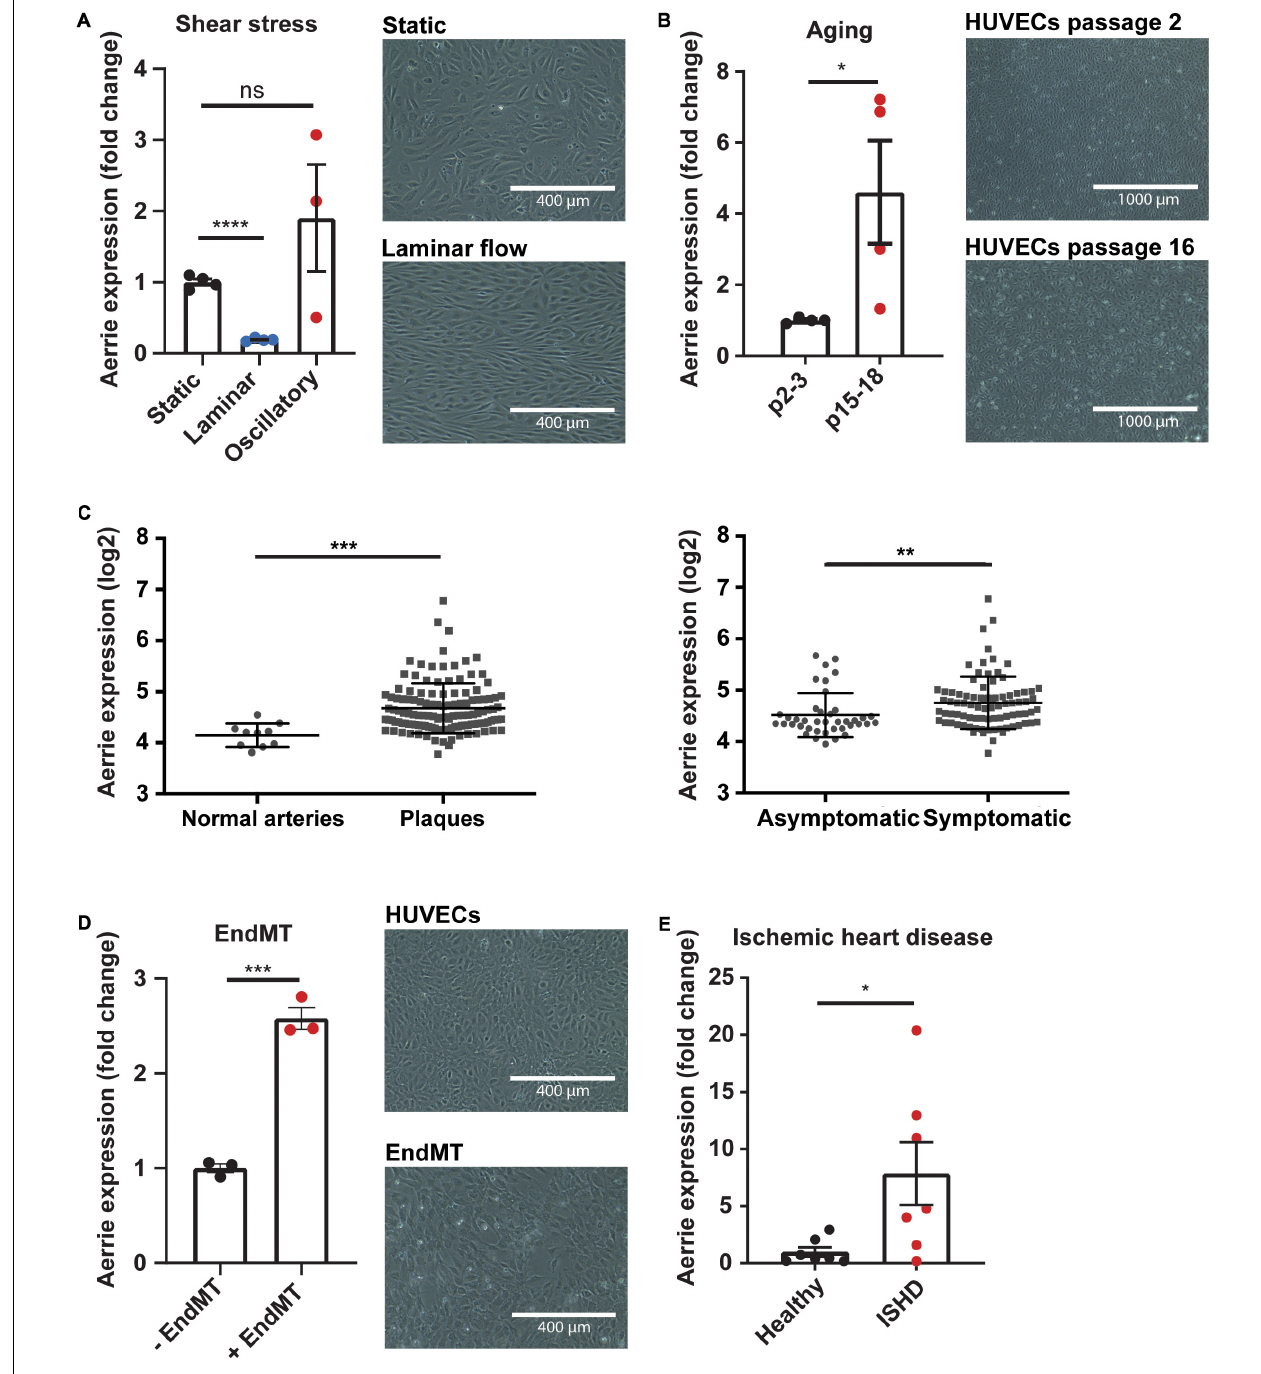
FIGURE 1 | The lncRNA Aerrie is expressed in endothelial cells and is regulated by aging, shear stress, and endothelial-to-mesenchymal transition (endMT). (A) Human umbilical vein endothelial cells (HUVECs) were exposed to laminar (72 h, 20 dyn/cm 2 ) and oscillatory flow (14 h, 20 dyn/cm 2 ). Expression levels of Aerrie were measured by real-time quantitative PCR (RT-qPCR). Expression values are relative to static condition and normalized to GAPDH mRNA ( n > 3). (B) Human umbilical vein endothelial cells (HUVECs) were artificially aged by passing frequently until senescence is reached. Expression levels of Aerrie were measured by RT-qPCR in early and late passages (p) ( n = 4). (C) Human atherosclerotic plaques were collected, and microarray profiled (GSE21545). Expression levels of Aerrie were plotted as normal healthy arteries ( n = 10) versus atherosclerotic plaques ( n = 127). From the atherosclerotic plaques, those from asymptomatic ( n = 40) and symptomatic patients ( n = 87) were distinguished and expression levels of Aerrie were plotted. (D) HUVECs were stimulated with IL-1 β and TGF- β 2 to induce endMT. Expression levels of Aerrie were measured by RT-qPCR ( n = 3). (E) Human heart tissue of the left ventricle was isolated from healthy donor ( n = 7) versus ischemic heart disease (ISHD) patients ( n = 7). Expression levels of Aerrie were measured by RT-qPCR. * p < 0.05; ** p < 0.01; *** p < 0.001; **** p < 0.0001; ns , not statistically significant.